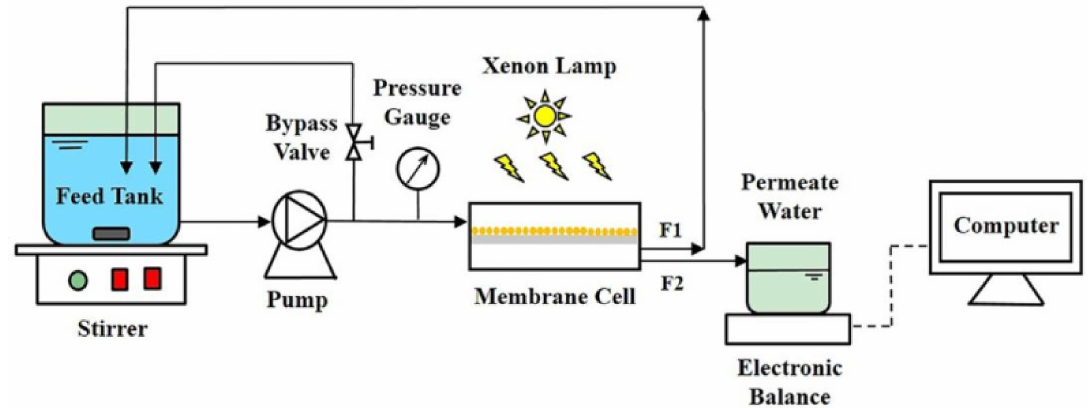
Figure 2. Photocatalytic membrane reactor operated in cross-flow filtration mode, where the feed solution is continuously recirculated tangentially to the membrane; reproduced with permission from [48], Copyright 2020,